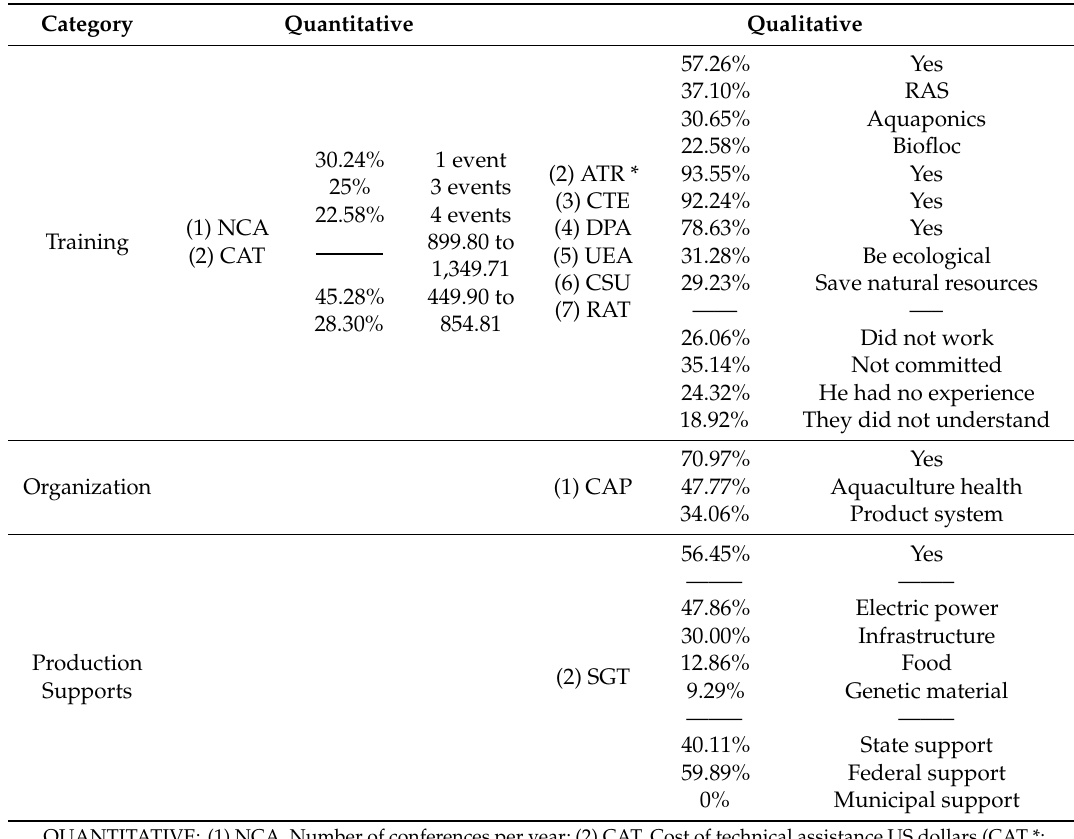
Table 6. Training, organization, and production support